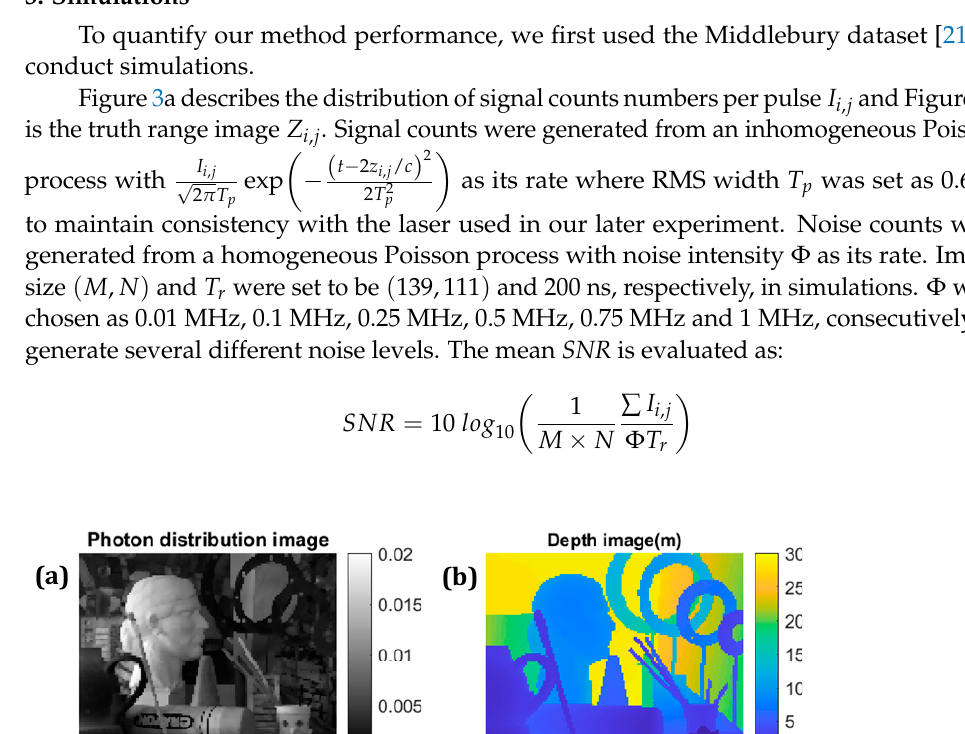
Figure 3. Middlebury dataset image for simulation. ( a ) Image of averaged signal photon per pulse; ( b ) depth image.